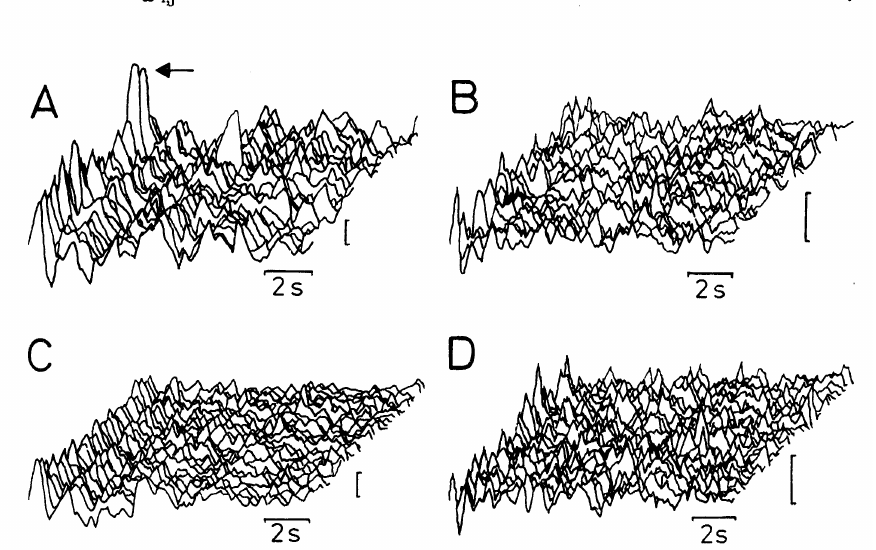
FIG. 3. Error curves from two subjects in their first (A,C) and fourth (B,D) experimental sessions (experiment I). The first 32 consecutive trials of each session are plotted. The first trials are the lowest. In the first sessions, a regular error pattern prevails, which with increasing skill is replaced by a random pattern. Arrow, see text. Note the different scale magnifying error curves in Band D by a factor of